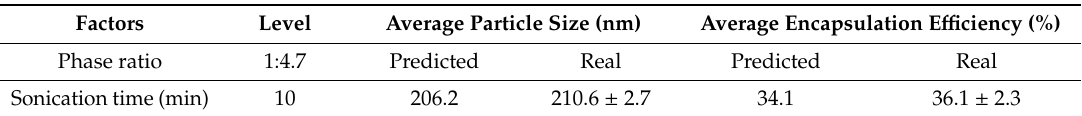
Table 5. Composition of the optimized formulation of DCT-loaded T f -conjugated PLGA NPs and predicted and actual